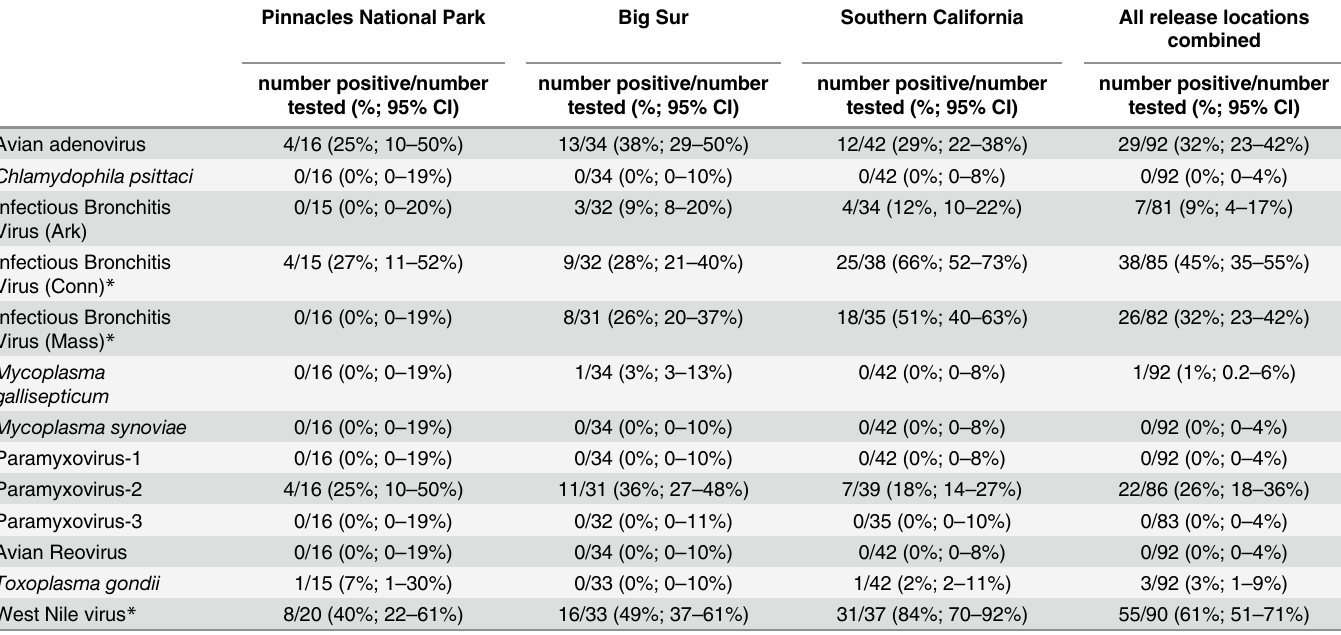
Table 1. Seroprevalence of potential pathogens in California condors from three release locations in California.